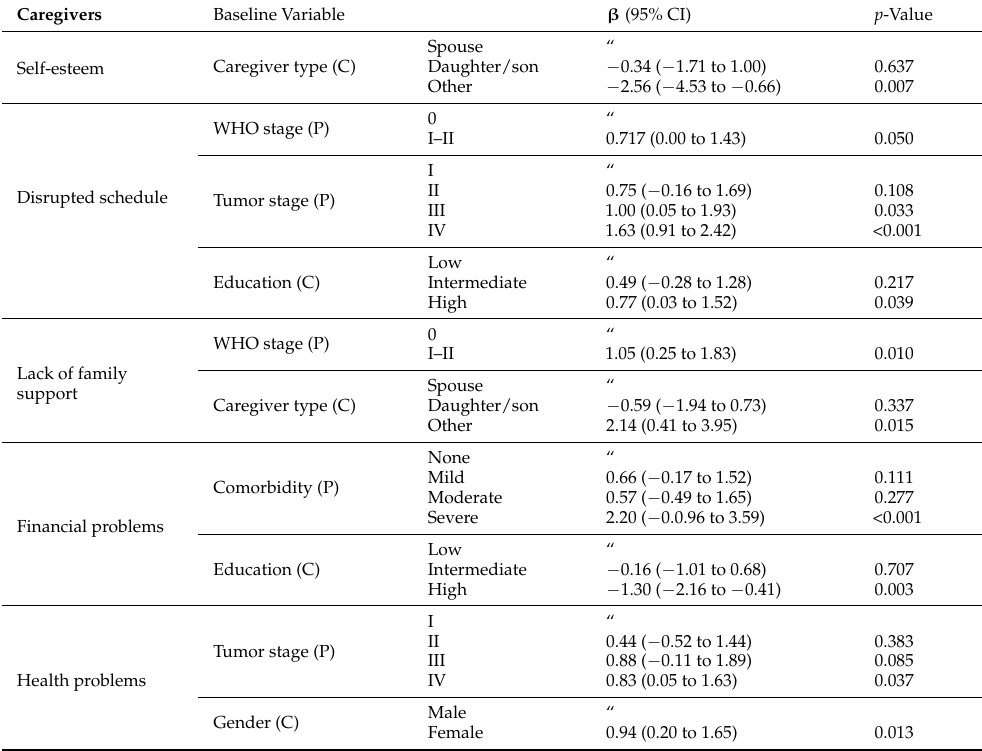
Table 3. Variables that were significantly associated with caregiver